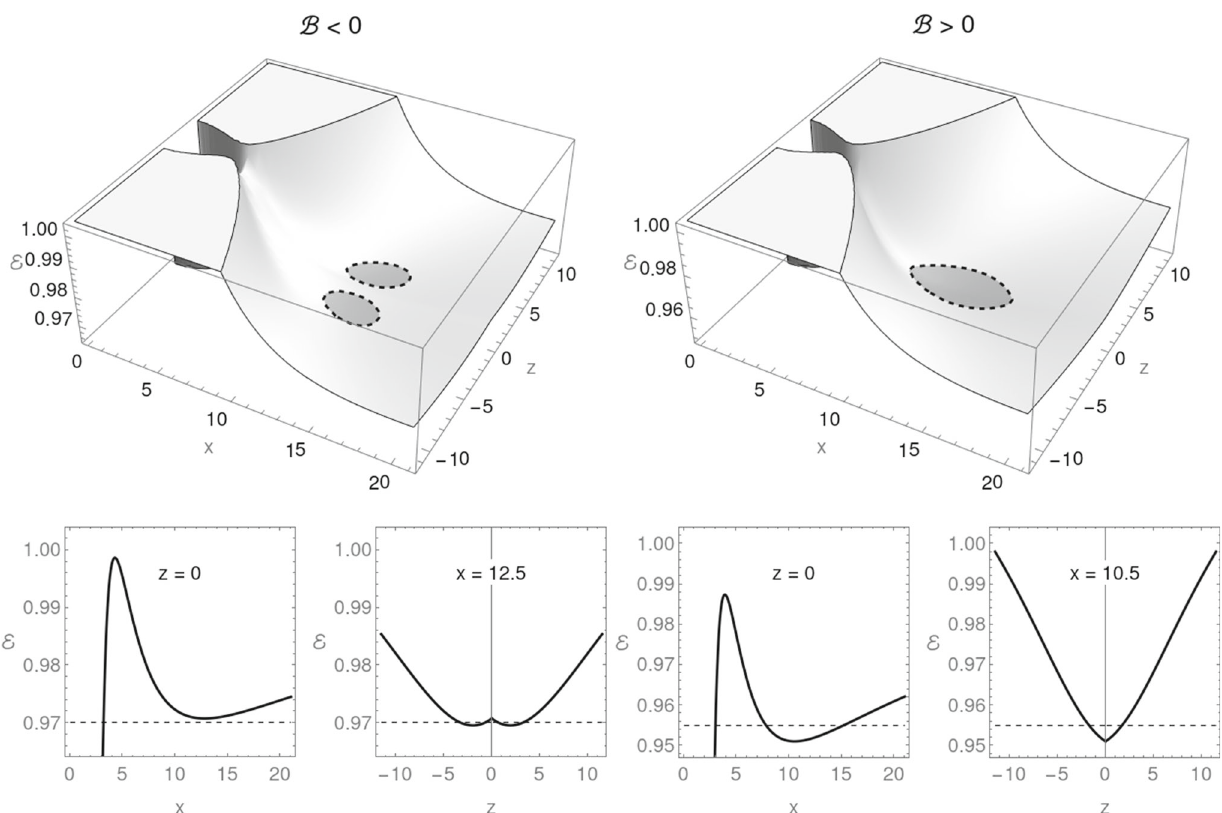
shows the sections of the effective potential at given energy and the cor- responding minima. Value of the parameter w has been set to w = 3 / 4, but similar behavior is observed for different values of w ∈ ( 0 , 1